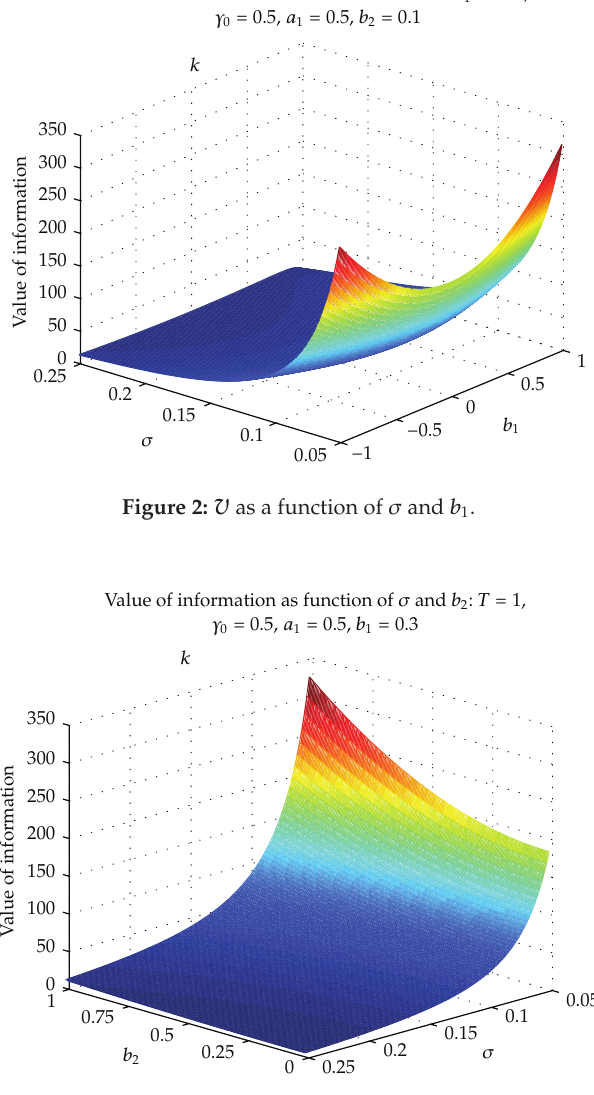
Figure 3: V as a function of σ and b 2